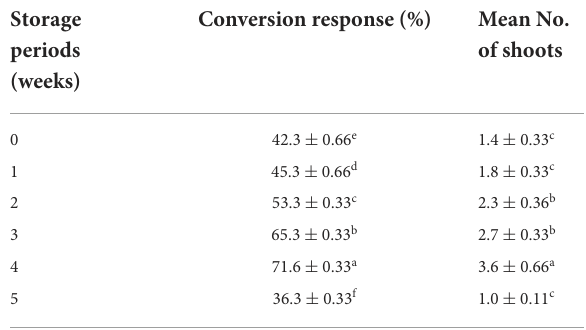
TABLE 7 Effect of low temperature (4 ◦ C) on the conversion of encapsulated NS into plantlets (means ± SE) on best treatment (8 weeks after